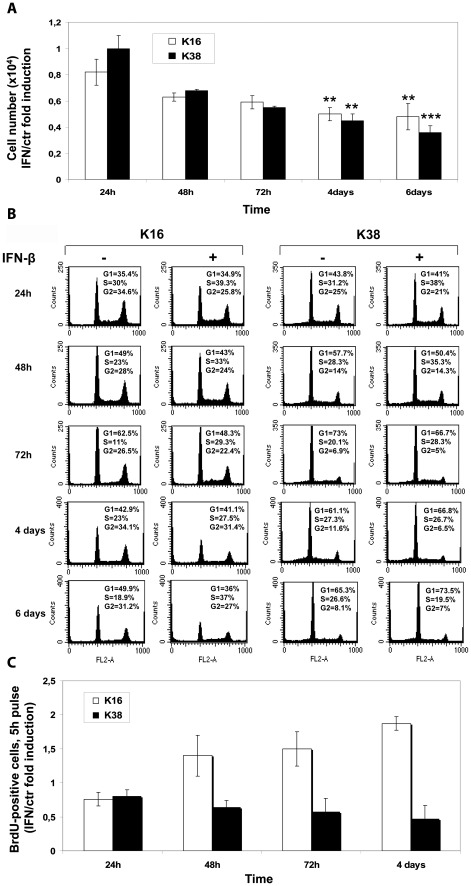
IFN-β affects cell proliferation in K16 and K38 cells.(A) IFN-β inhibits cell proliferation in K16 and K38 cells. Cells were seeded in triplicate at 105 cells per 35 mm dish and, after 24 h, IFN-β was added to the cultures for the indicated times. IFN-β treated and control cells were counted in a hemocytometer and viability was evaluated by trypan blue exclusion. Data represent means ± s.d. of three independent experiments. ** = p<0.01; *** = p<0.001. (B) IFN-β treatment differently affects cell cycle progression of K16 and K38 cells. K16 and K38 cells were treated with IFN-β for the indicated time points. DNA staining was performed by incubating cells in PBS containing 0.18 mg/ml propidium iodide and 0.4 mg/ml DNase-free RNase. Cells were analysed on a FACScan flow cytometer. DNA profiles, derived from one representative experiment of three performed, are shown. (C) IFN-β treatment differently affects DNA synthesis in K16 and K38 cells. To determine the number of S-phase nuclei, cells were plated in triplicate at 105 cells per 35 mm dish, treated with IFN-β for different time points and incubated with 50 µM BrdU for the last 5 hours. BrdU treated samples were then fixed and stained with an anti-BrdU monoclonal antibody followed by a rhodamine conjugated goat anti-mouse antibody. BrdU-positive cells were counted under a fluorescence microscope. Data represent means ± s.d. of three independent experiments.